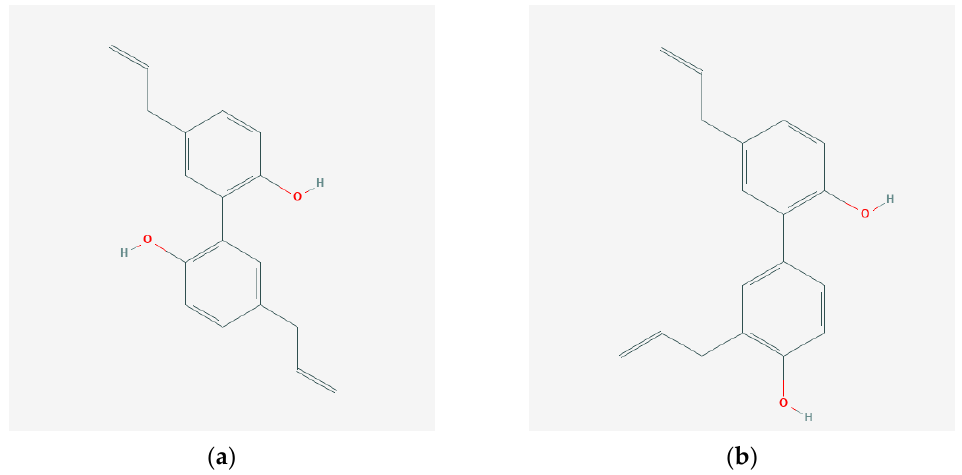
Figure 1. Structural formulas of magnolol ( a ) [19] and its optical isomer—honokiol ( b ) [20].